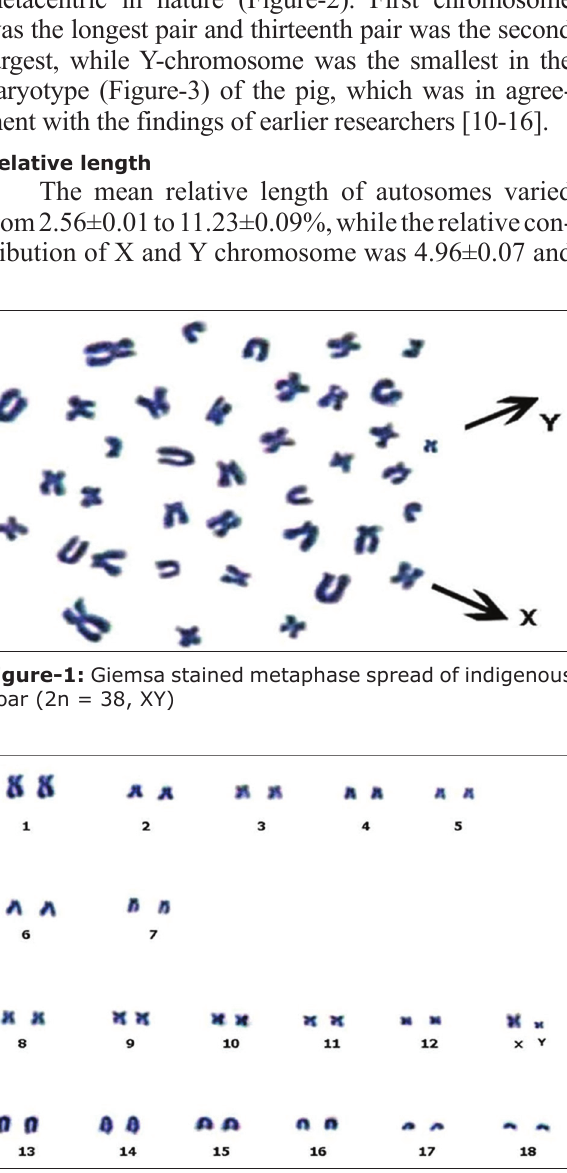
Figure-2: Giemsa stained Karyotype of indigenous Boar (2n = 38, XY)